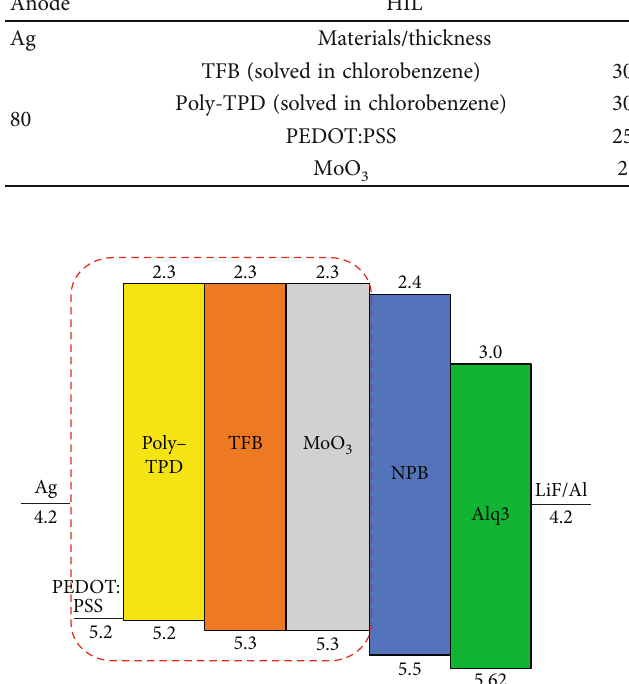
Figure 4: Energy band diagram for TE-OLEDs with di ff erent hole injection materials.